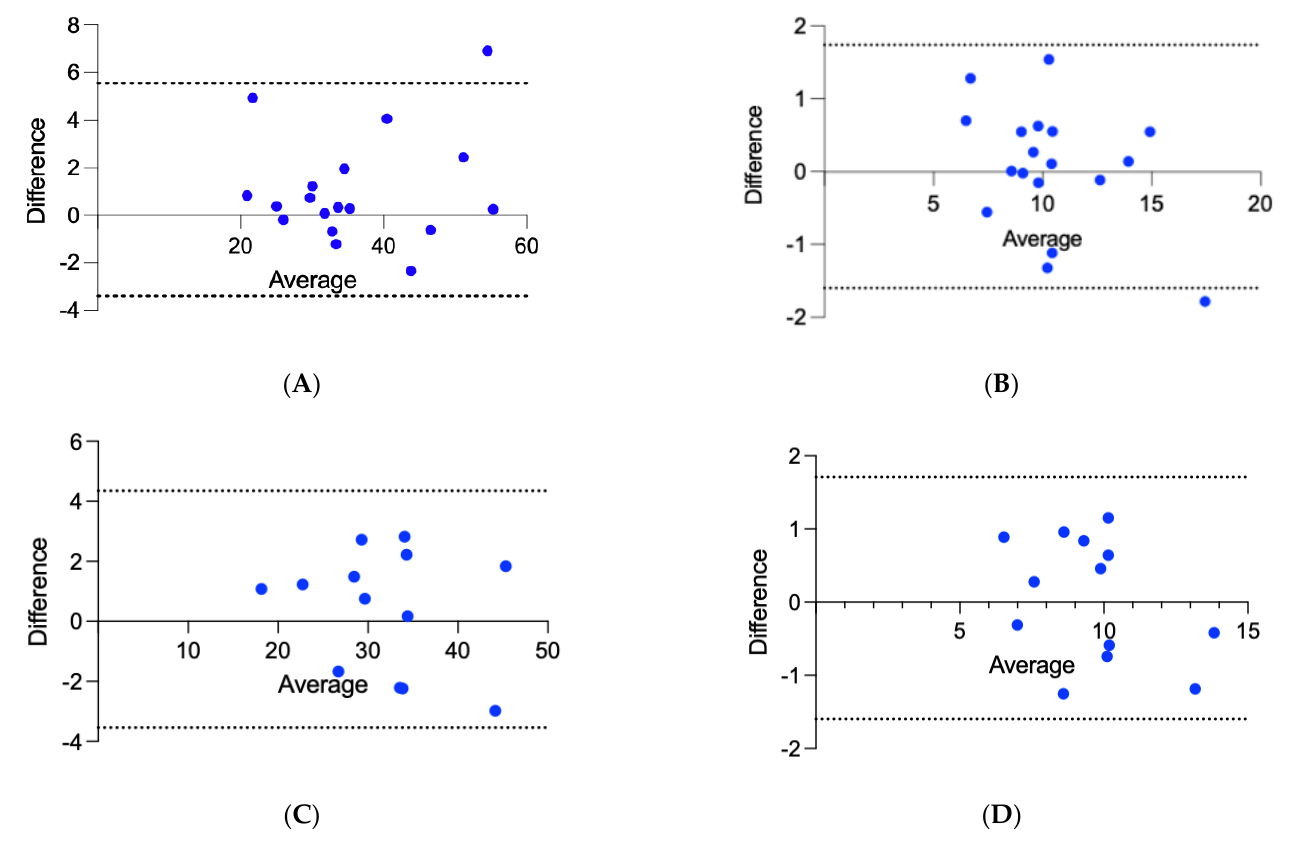
Figure 2. Bland Altman plots for inter-observer measurements of ( A ) anterior and ( B ) paraspinal muscle areas and intra-observer measurements of ( C ) anterior and ( D ) paraspinal muscle areas. Central solid line is representative of the bias, with dotted lines being representative of 95% limits of